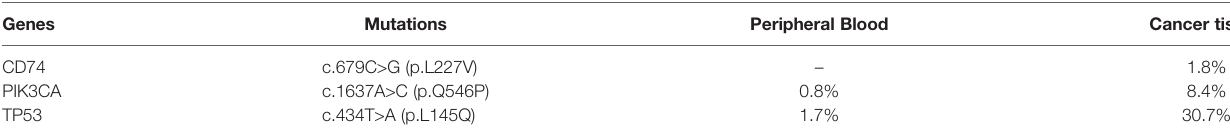
TABLE 1 | Mutations and their abundance detected by NGS (Geneseeq Technology